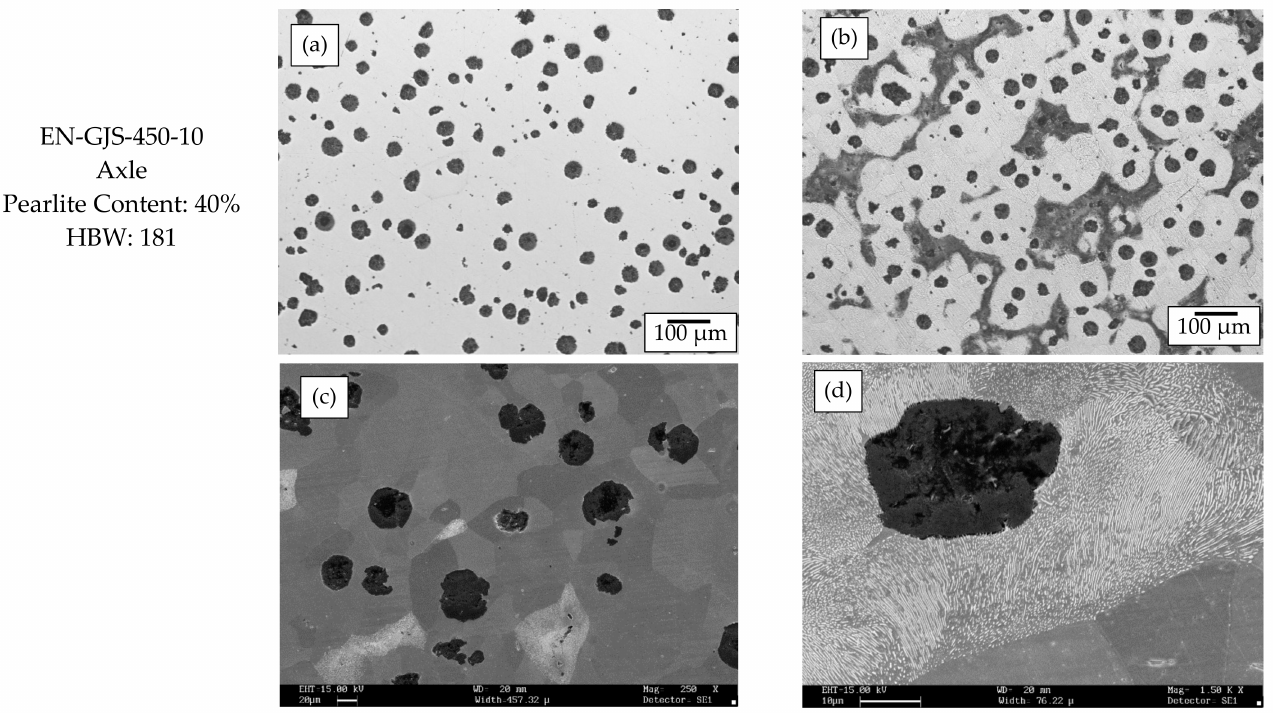
Figure 7. Microstructure of specimens made of EN-GJS-450-10 observed by ( a , b ) optical microscope and by ( c , d ) SEM. Microstructure ( a ) unetched and ( b ) after Nital 4% etched.